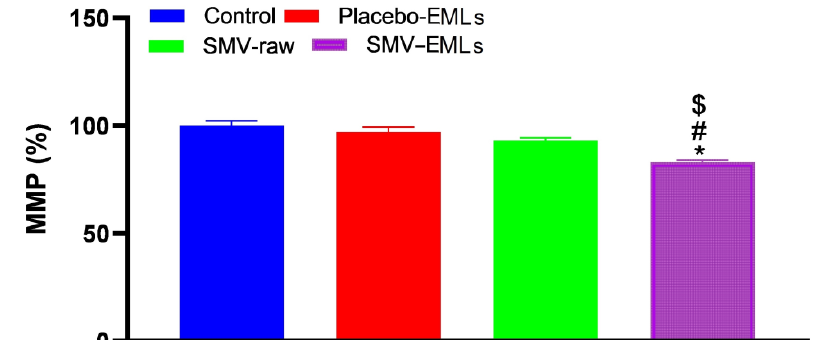
Figure 9. Impact of Placebo-EMLs, SMV-raw, or optimized SMV-EMLs treatments on MMP of MCF-7 cells. Values were normalized with respect to control untreated MCF-7 cells and are expressed as the percent variation of MMP. * Significantly different vs. Control ( p < 0.05); # Significantly different vs. Placebo-EMLs ( p < 0.05); $ Significantly different vs. SMV-raw ( p < 0.05).